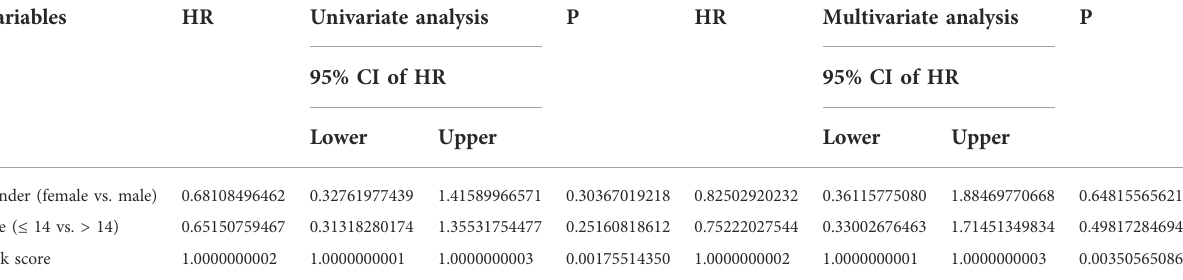
TABLE 1 Variables associated with the overall survival in osteosarcoma: univariate and multivariate analyses. Variables HR Univariate analysis